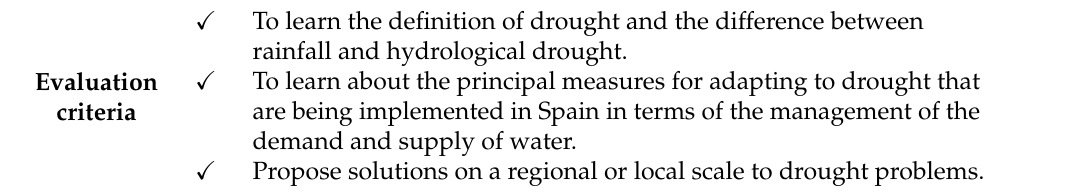
Table 5. Activities proposed for teaching about drought on the Mediterranean coast (2nd year of